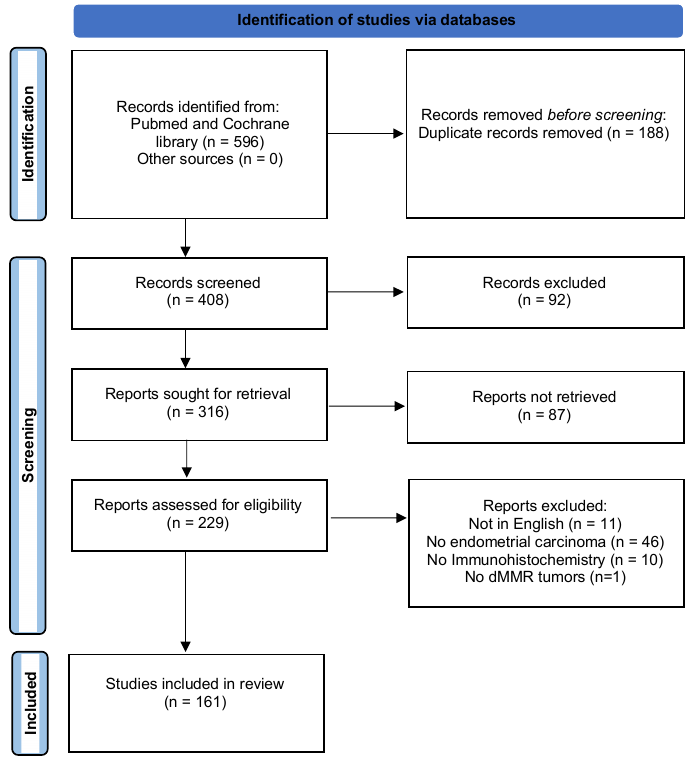
Figure 1. PRISMA Figure 1. PRISMA flowchart.